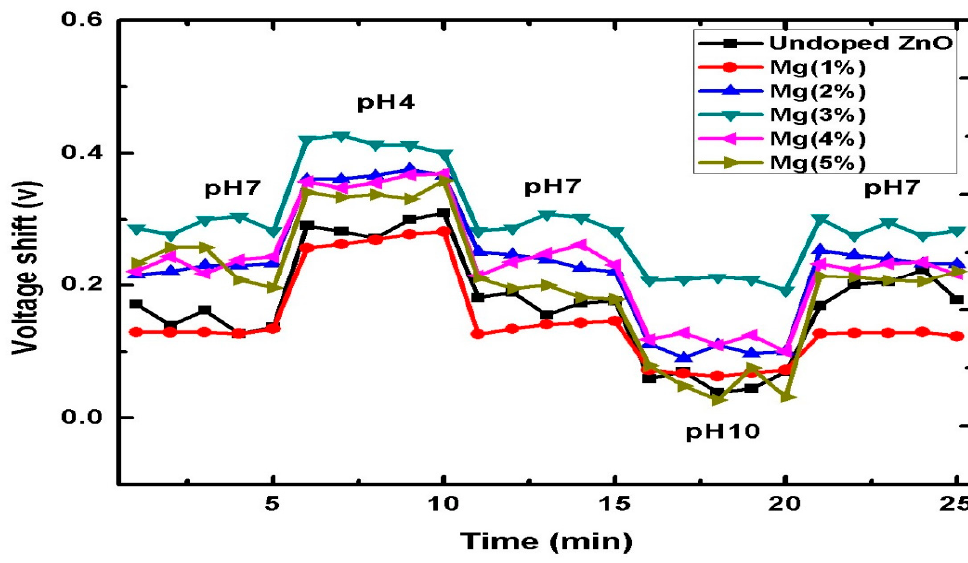
Figure 9. The hysteresis of the ZnO and Mg-doped ZnO nanorod sensing membranes. Drift is defined as the gradual change in the response of the sensors over time, while the pH value remains constant. The differences in the amount of surface sites over time are essentially due to the change in the chemical modification of the dielectric surface, consequently leading to an increase in the threshold voltage [73]. The difference in the reference voltage ( ∆ V ref ) is given